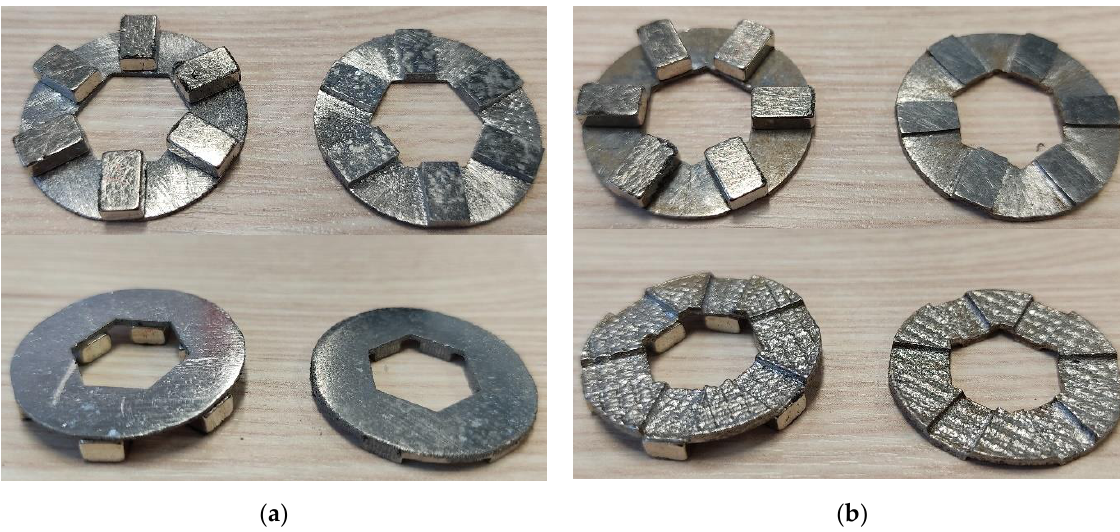
Figure 11. ( a ) Prototype of the initial design of the coupling; ( b) prototype of the optimized design on the coupling.